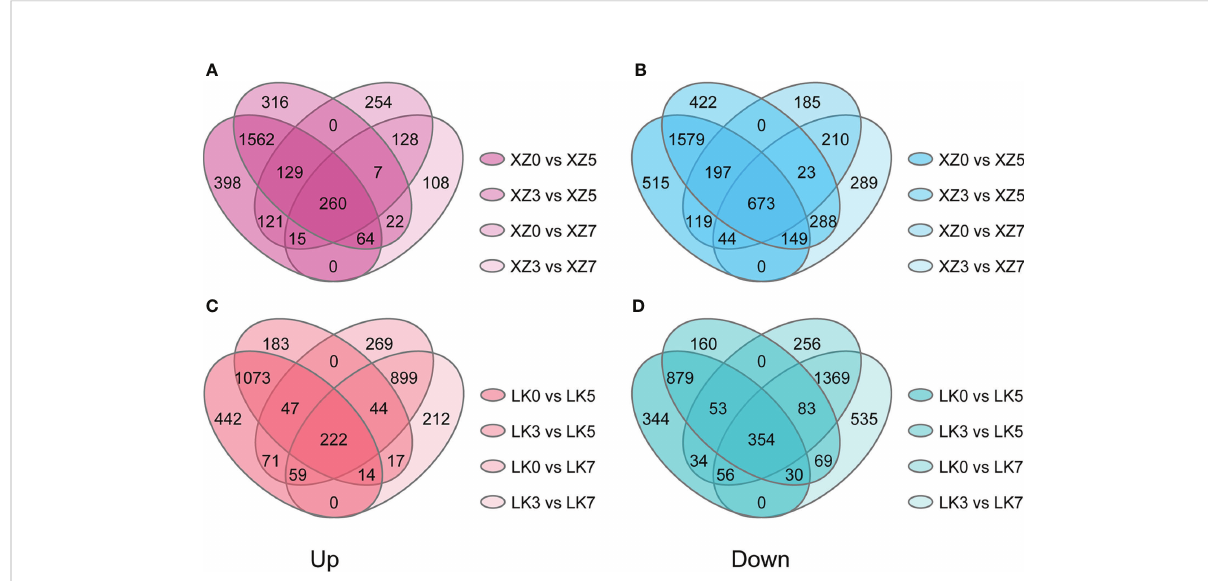
FIGURE 5 Drought-responsive genes in XZSN and LK3. (A) Upregulated drought-responsive genes in XZSN, (B) downregulated drought-responsive genes in XZSN, (C) upregulated drought-responsive genes in LK3, and (D) downregulated drought-responsive genes in